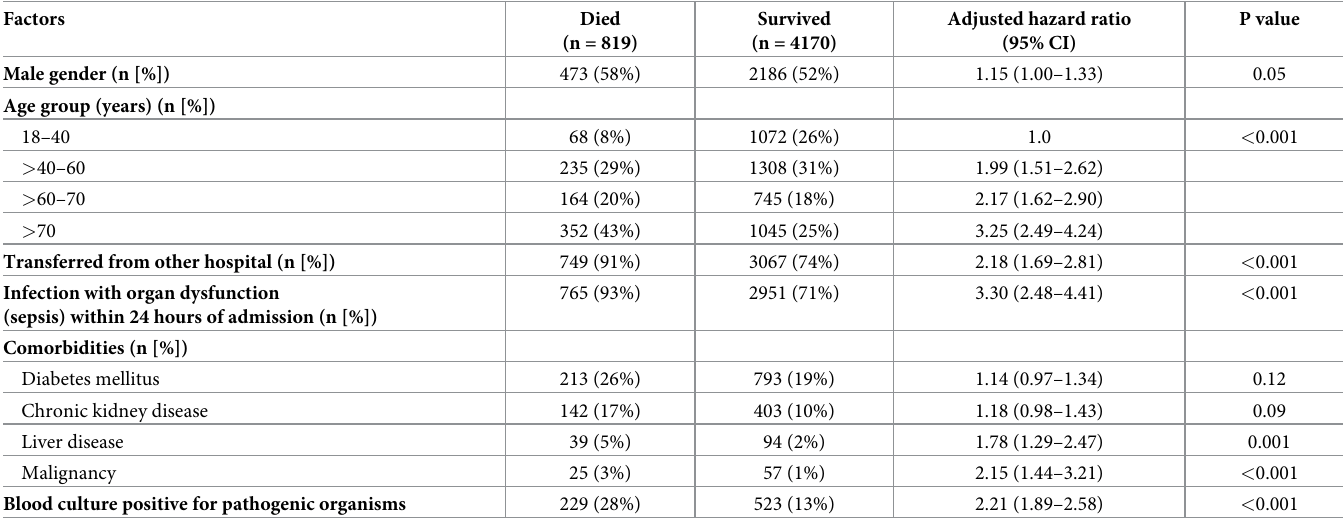
Table 4. Factors associated with 28-day mortality using multivariable Cox proportional hazards